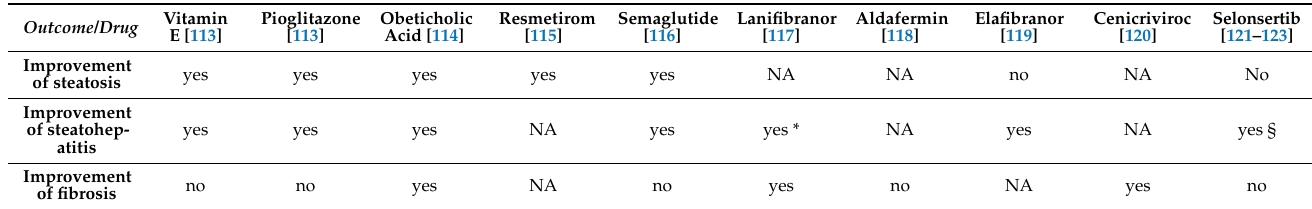
Table 2. Principal randomized controlled trials for NAFLD